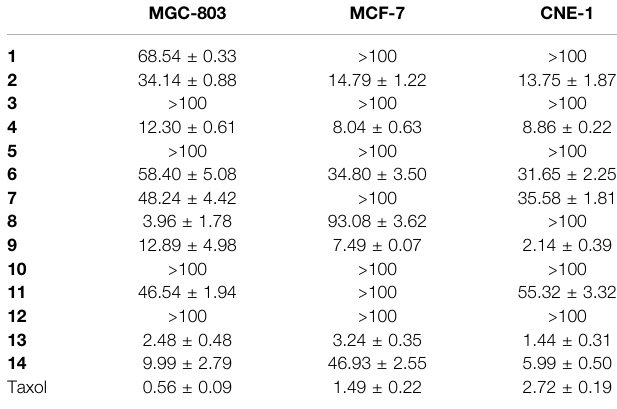
TABLE 4 | Cytotoxicity of compounds 1 – 14 (IC 50 , μ